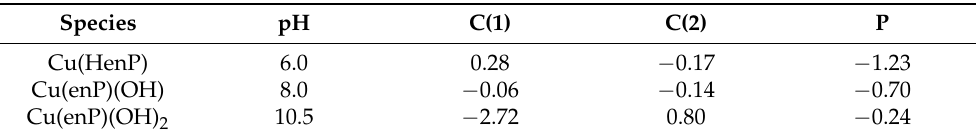
Table 6. NMR differences between signal positions for the ligand in the complex in relation to the free ligand